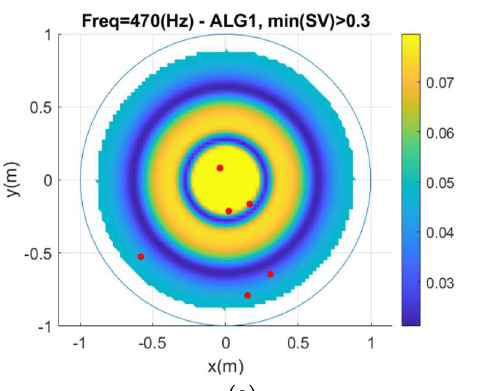
Figure 9. Relative error ( a1 , b1 ) and smallest singular value ( a2 , b2 ) computed for the two algorithms ALG1 ( a1 , a2 ) and ALG2 ( b1 , b2 ), considering different acceptable values for min(SV) of 0.05, 0.1, 0.2 and 0.3. The same color pattern is used for all figures.